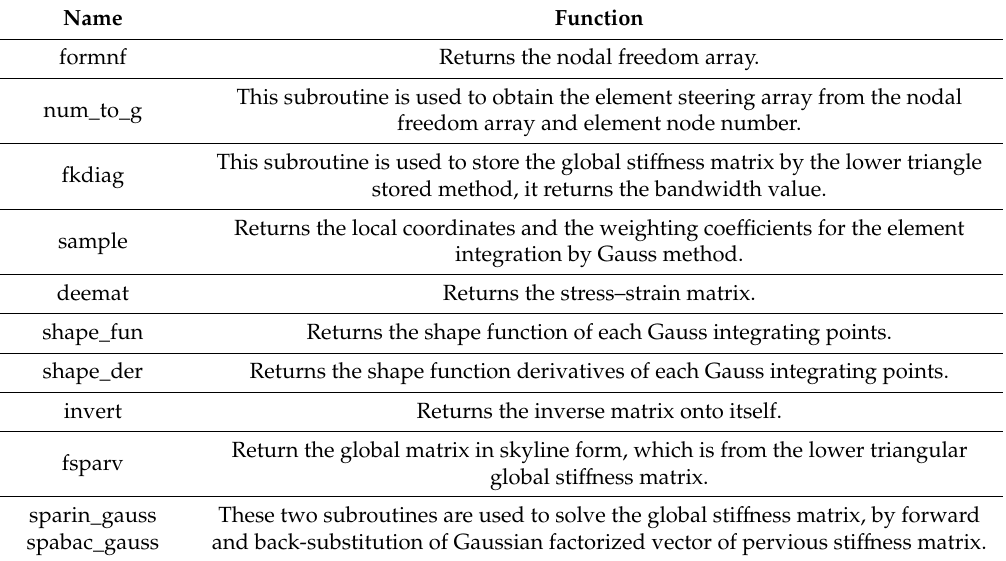
Table 1. List of the standard subroutines for the in-house